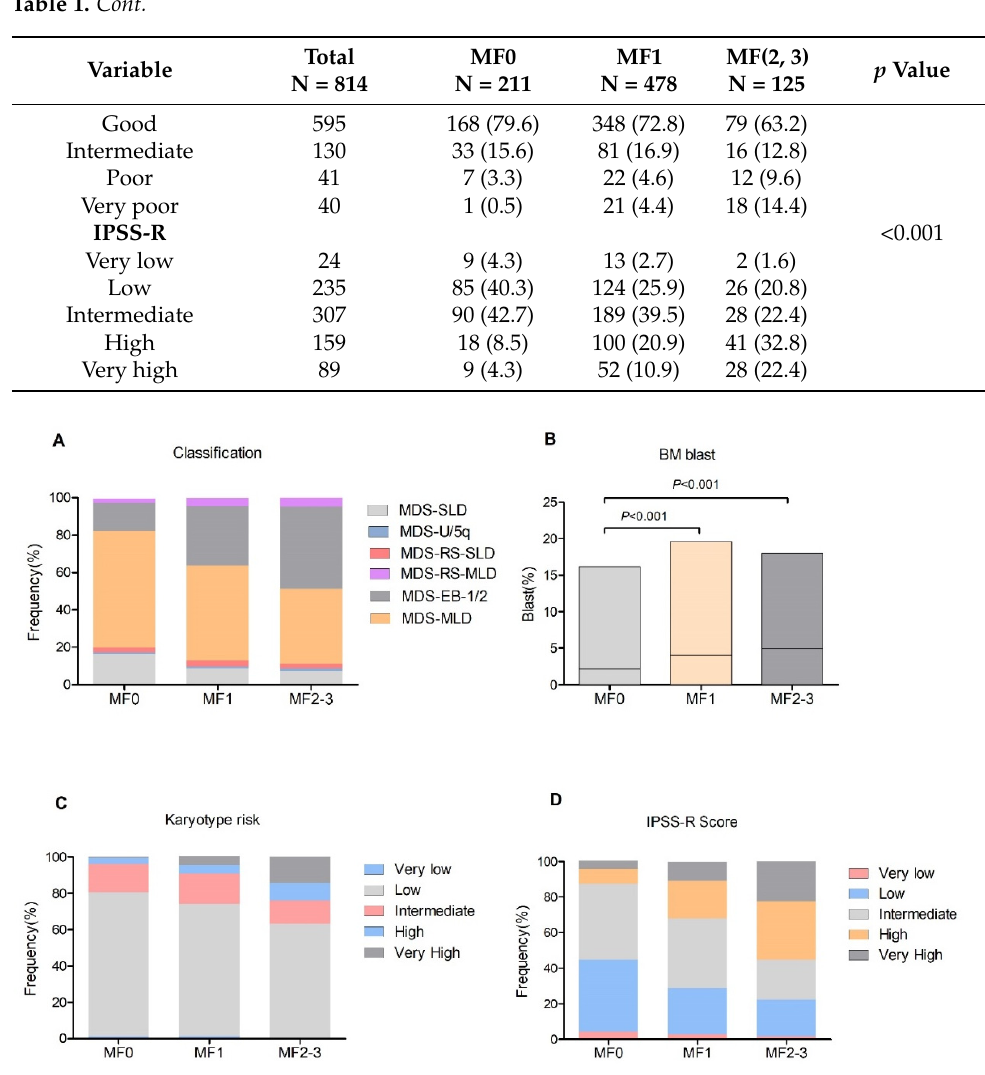
Figure 1. Clinical features of patients with BM fibrosis. ( A ), disease classification among different grade of fibrosis; ( B ), BM blast levels; ( C ), karyotype distribution according to IPSS-R; ( D ), IPSS-R scores.